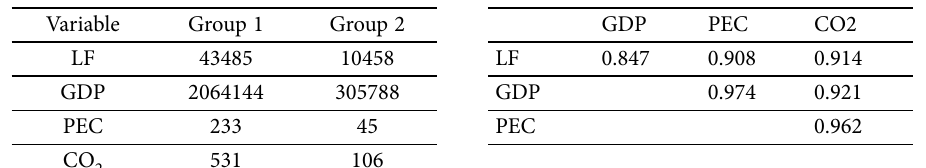
Table 2. Average values in the groups Table 3. Correlation